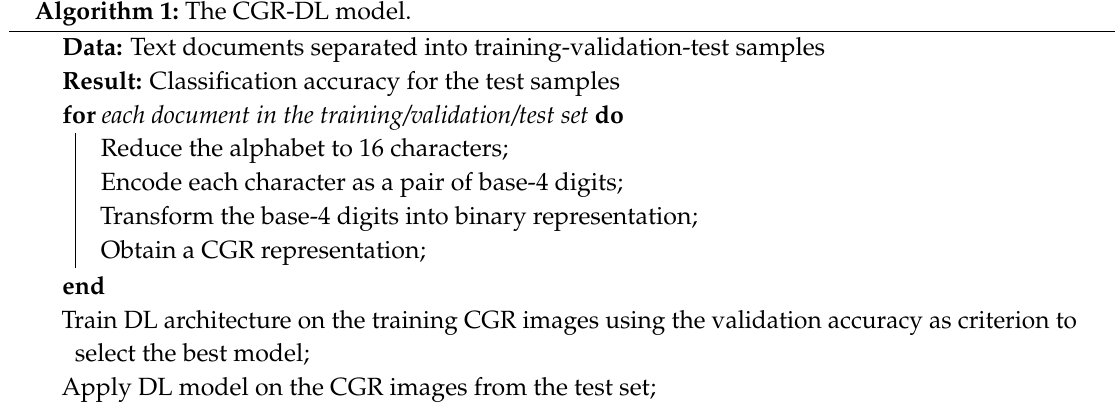
Algorithm 1: The CGR-DL model. Data: Text documents separated into training-validation-test